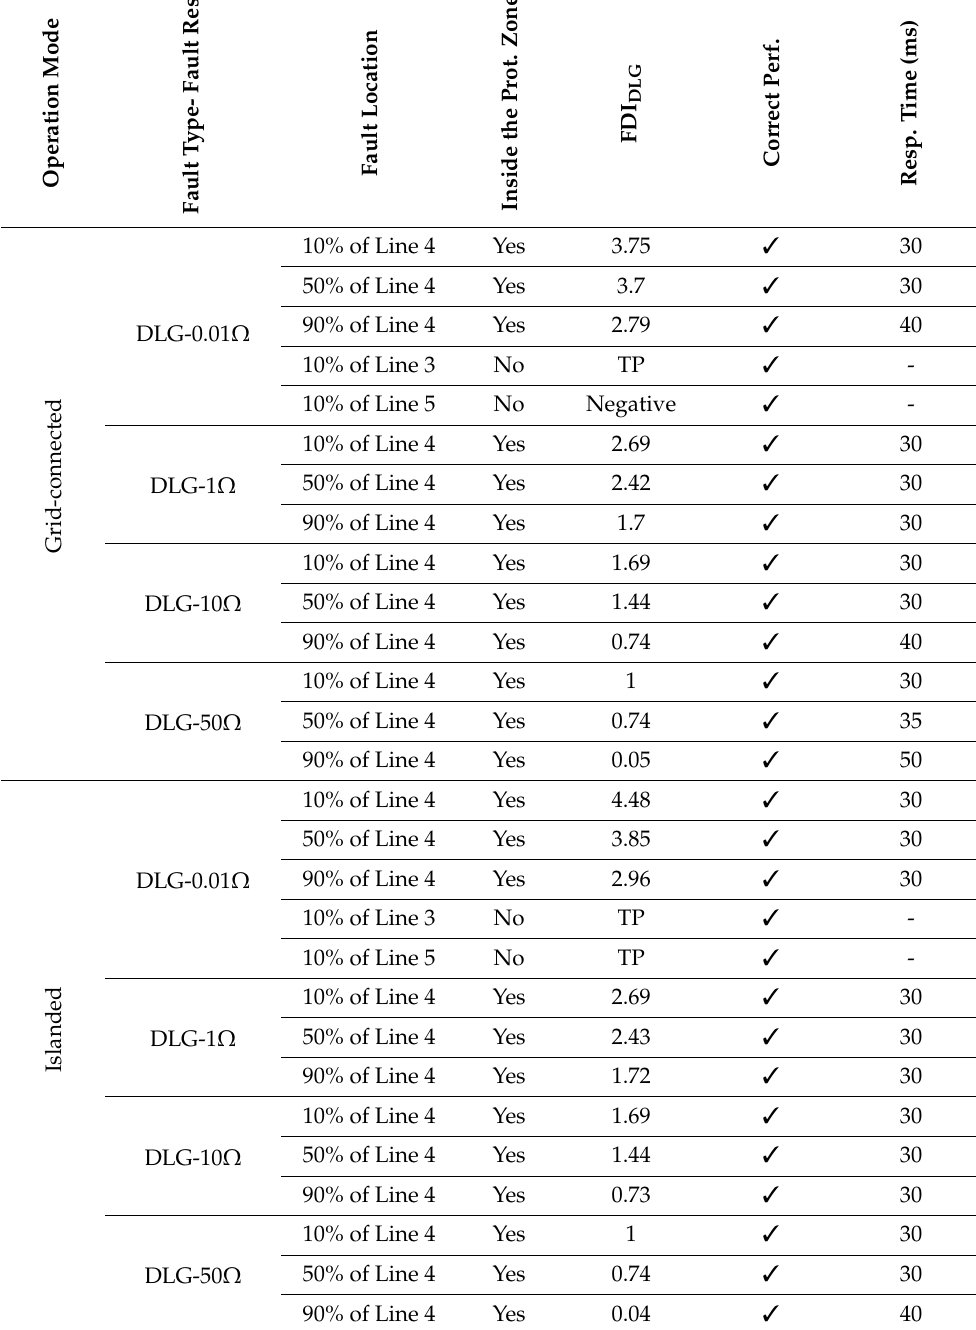
Table 2. Performance of proposed main scheme in DLG